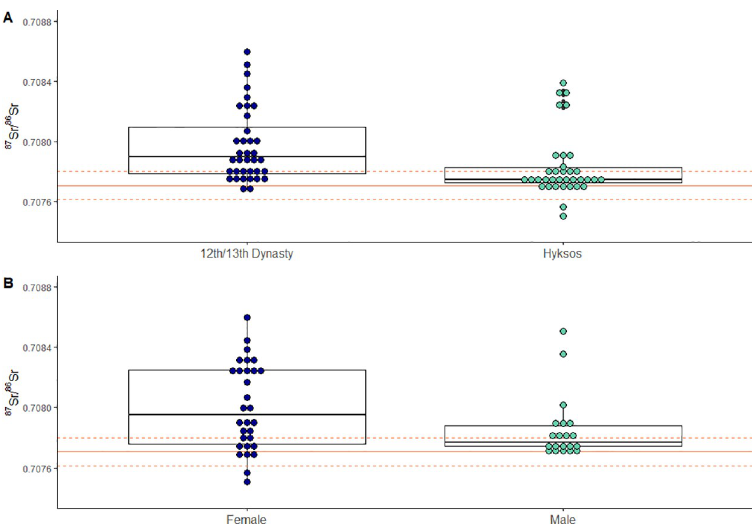
Fig 5. Comparing 87 Sr/ 86 Sr values by time period and sex. (A) Comparison of 87 Sr/ 86 Sr values of pre-Hyksos and Hyksos individuals. (B) Comparison of 87 Sr/ 86 Sr values of females and males.